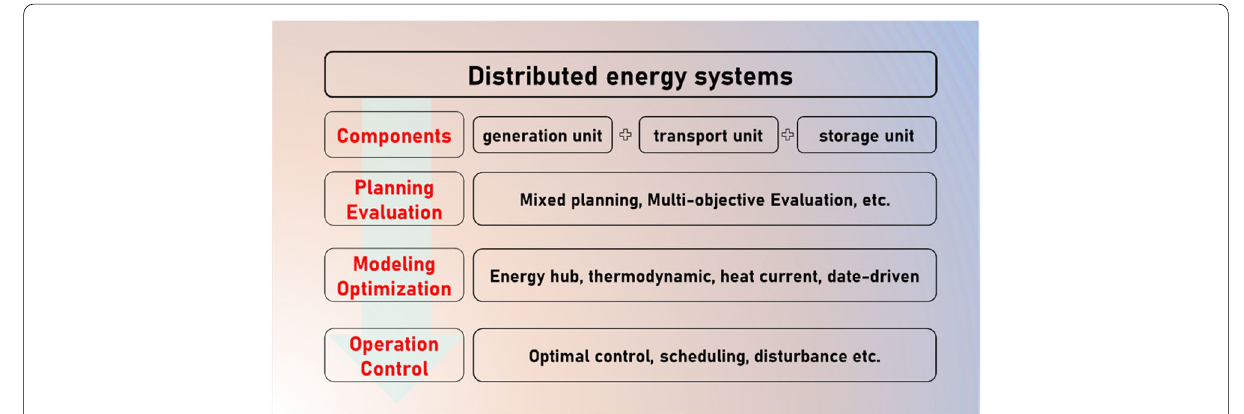
Fig. 4 Review framework of distributed energy